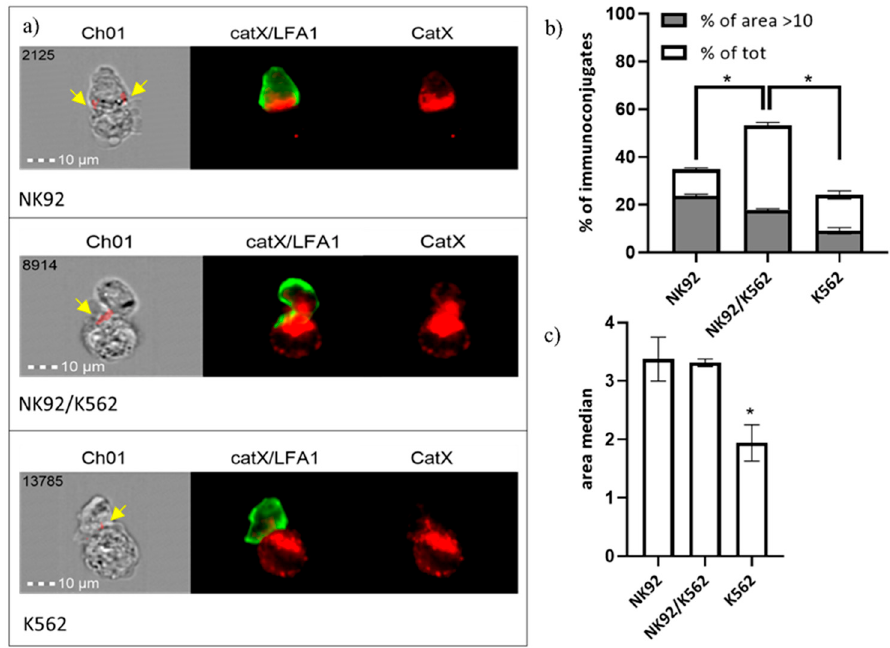
Figure 6. Categorization of NK-92/K-562 immunoconjugates, based on predominant cathepsin X localization. ( a ). Furthermore, the degree of cathepsin X and β 2 co-localization was compared between these three groups. by comparing the size of co-localization area ( b ) and median area value ( c ). * p < 0.05.